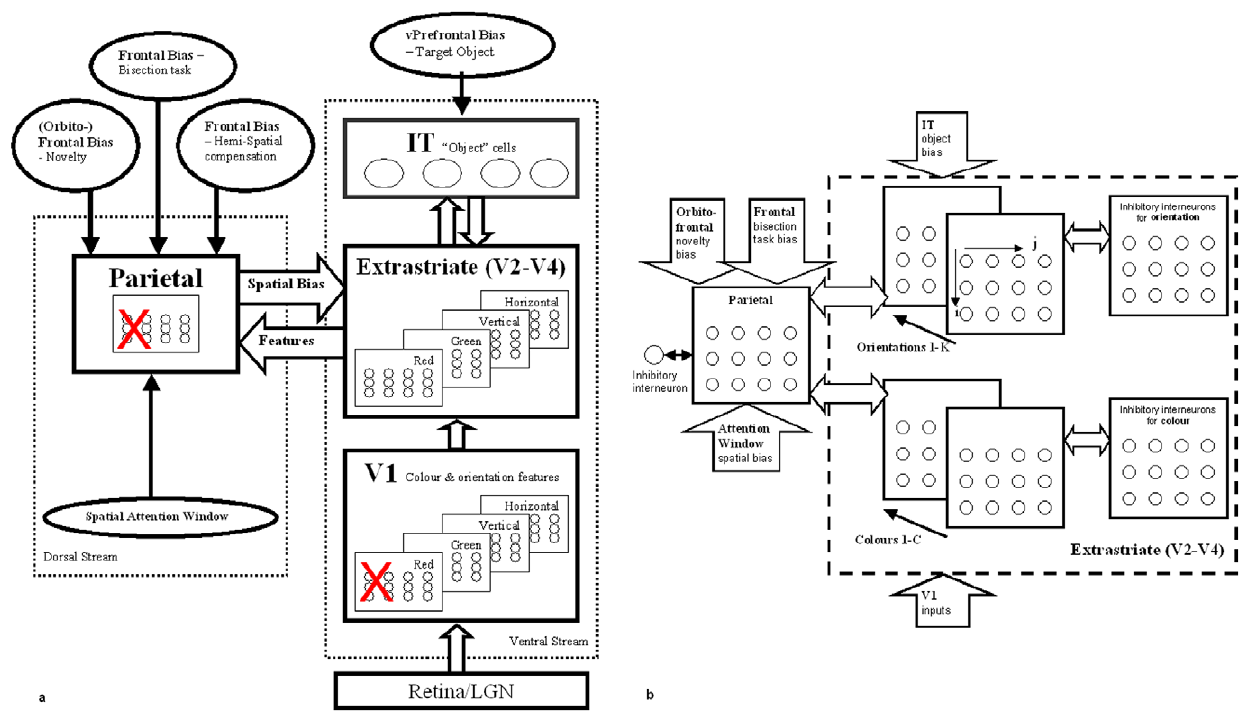
Figure 1. Model Architecture. a. Overview of the modules and connections. External biases to the system are shown as ovals. (Note that the actual number of cells in V1, extrastriate and parietal modules are more than shown. Typically several hundreds of neurons exist in each layer.) b. The inhibition and biases influencing competition in the extrastriate and parietal modules. These modules are reciprocally connected. Competition within the extrastriate module operates within each feature type at each spatial location. Neurons in the parietal module compete to determine which spatial location wins the competition for attention. Further description is given in the appendix.